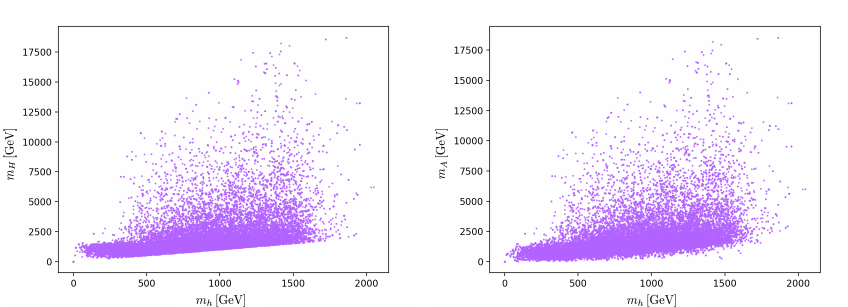
Figure 4. Scatter plot in the plane m h , pole vs m H , pole (left) and m h , pole vs m A , pole (right) for calculated values when including two-loop corrections. Here we have also included a check on perturbativity to the scalar loop